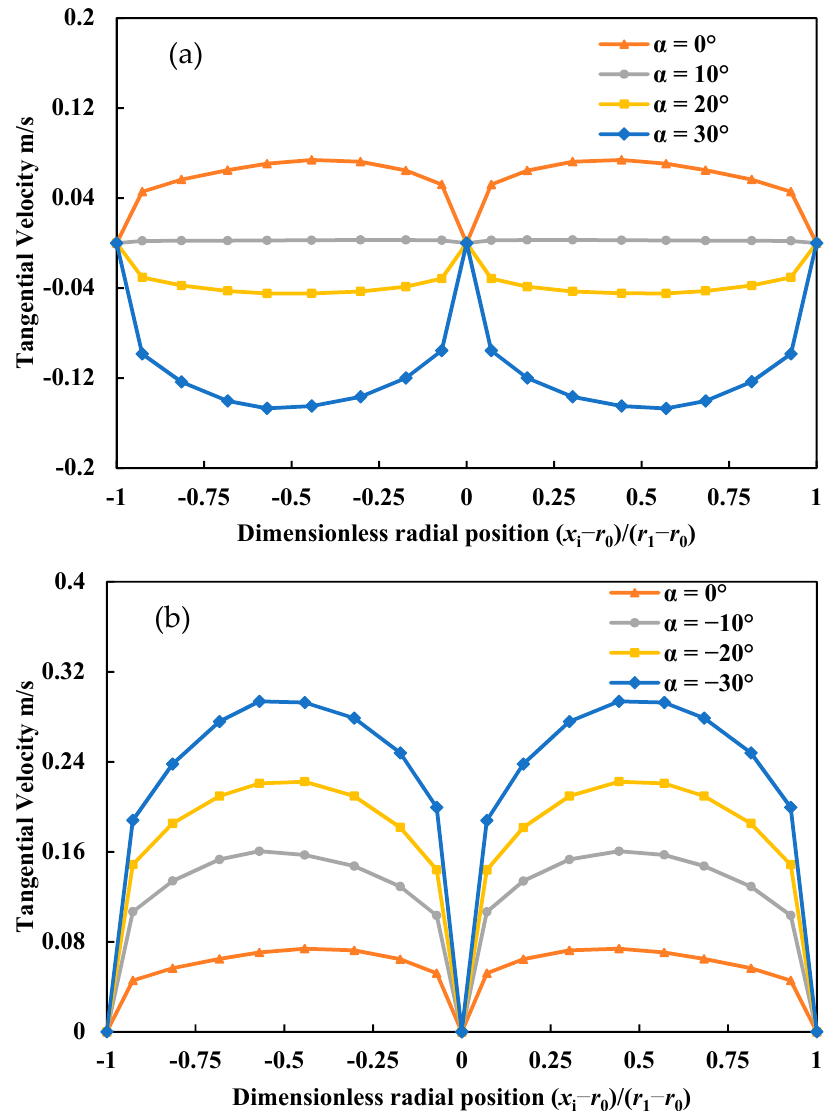
Figure 11. Dimensionless radial profiles of tangential velocity with different helical angles for the straight blade at z = 1.0 m cross section ( a ) positive blade and ( b ) negative blade.